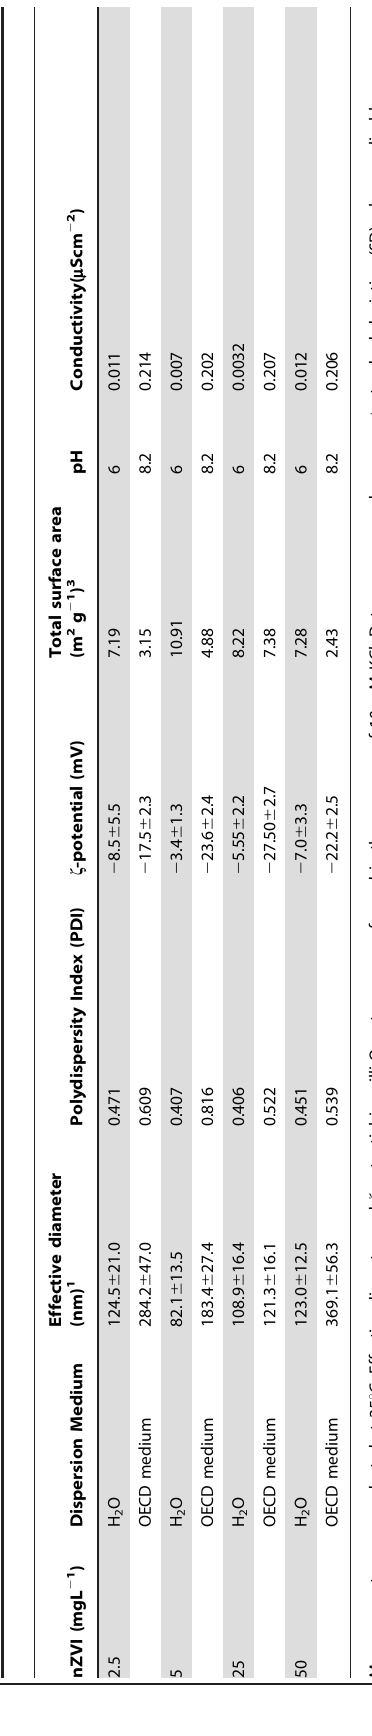
were studied by TEM and FTIR analysis ( Figure 6 .). As shown in Figure 6.b, d , the presence of electron-dense particles surround- ing the external cell wall of the micro algae was identified at 0.075 mgL 2 1 and 2.5 mgL 2 1 of nZVI. However, they were absent in control cells and 0.5 mgL 2 1 nZVI treatment ( Figure 6.a , c , respectively). XEDS analysis assigned Fe as the main constituent of those particles ( Figure 6.i, j ). Furthermore, FTIR analysis ( Figure 6.f and h ) revealed significant changes to the IR signals of algal cell where cell-nZVI attachment occurred (0.075 mgL 2 1 and 2.5 mgL 2 1 nZVI treatments). These changes consisted of a significant reduction of peak absorption at wavenumbers characteristic of asymmetric (2924 cm 2 1 ) and symmetric (2853 cm 2 1 ) sp 3 C-H stretching vibrations, O-H stretching (3222 cm 2 1 ) and bending (1654 cm 2 1 ) vibrations in hydroxyl functional groups and C= O stretching vibration (1743 cm 2 1 ) of carbonyl functional groups [26]. Interestingly, IR signals remained almost unchanged in the 0.5 mgL 2 1 treatment ( Figure 6.g ) compared to control signal ( Figure 6.f